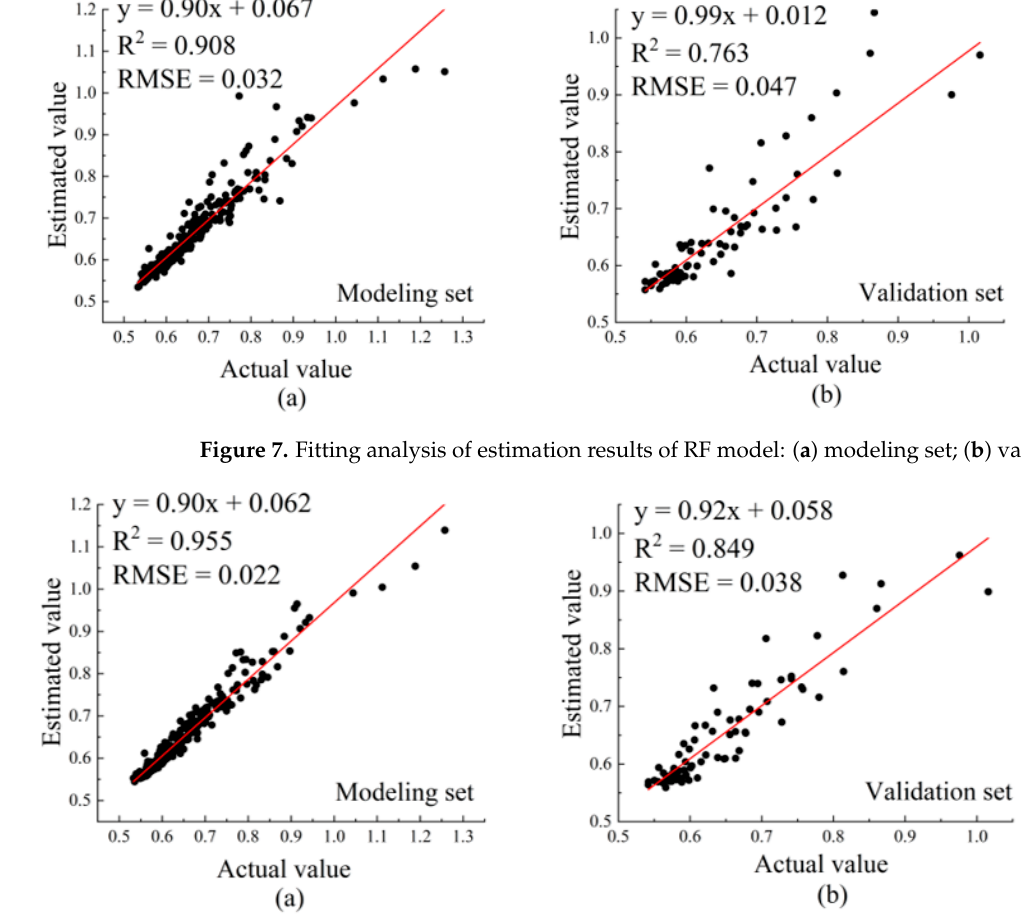
Figure 6. Iteration procedure of SSA.